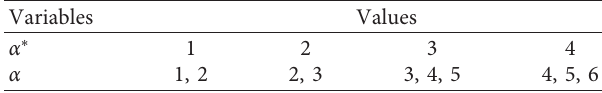
Table 3: The corresponding values of α and α ∗ if α ∗ ≤ 4. Variables